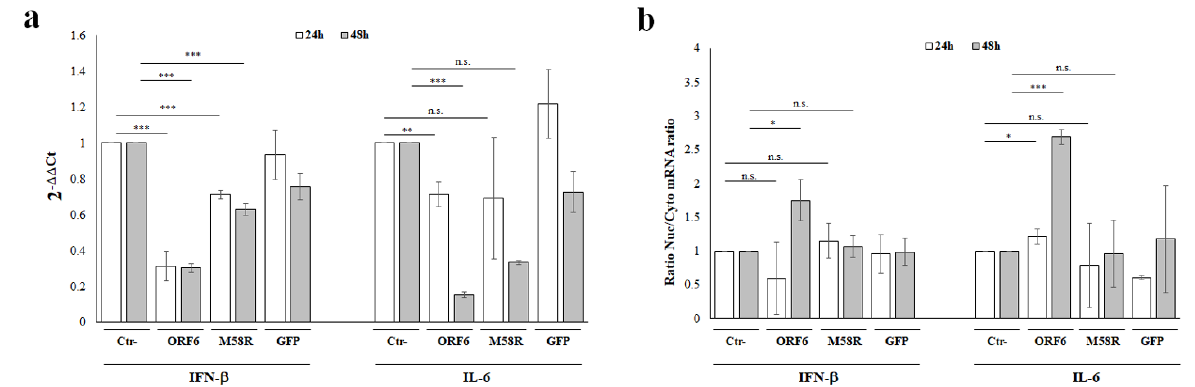
Figure 6. ORF6 blocks mRNA nuclear export along with transcriptional inhibition. ( a ) The effects at transcriptional level of ORF6 on IFN-β and IL-6 expression were evaluated in A549 cells. Total RNA was purified from empty vector (Ctr-), green-fluorescent protein (GFP), ORF6, or its M58R mutant transfected cells collected at both 24 h and 48 h post-transfection. Specific IFN-β and IL6 mRNA content was detected by quantitative reverse-transcription polymerase chain reaction (RT-qPCR). RNaseP gene expression was used for relative quantification based on 2 − ∆∆ Ct method. ( b ) Total RNA was purified from A549 nuclear and cytoplasmic cellular fractions from negative control (Ctr-), green-fluorescent protein (GFP), ORF6 or its mutant M58R expressing cells, collected at both 24 h and 48 h post-transfection. Relative quantification of IFN-β and IL6 mRNAs was performed by 2 - Ct method and the ratio between nuclear and cytoplasmic specific mRNAs content was used as a comparative method. ( a – b ) Three ( n = 3) independent experiments were performed and representative data are presented as mean values ± standard deviations. Significance was evaluated as p < 0.05 (*** p < 0.0005, ** p < 0.005, * p < 0.05, n.s. not significant).